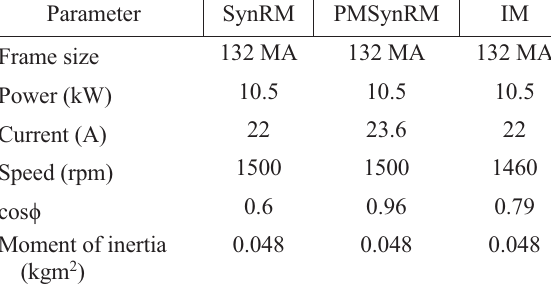
Table 2. Rated parameters of the studied motors